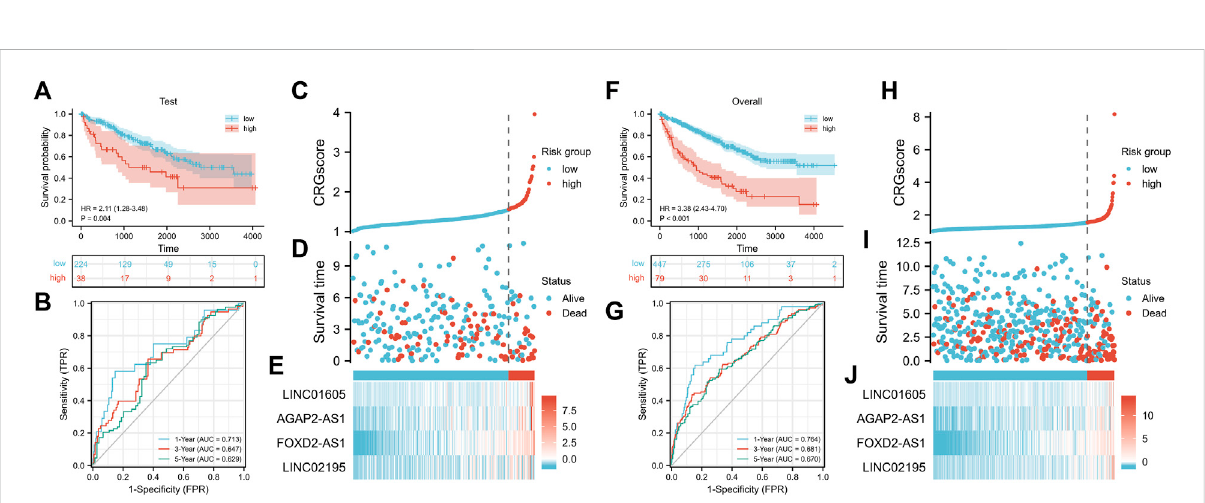
FIGURE 6 Veri fi cation of the prognostic signature. (A) Survival analysis of the CRGscore-de fi ned test cohort. (B) Time-dependent ROC curves. (C – E) Distribution of the CRGscore (C) , OS outcomes (D) , and hub lncRNAs expression (E) in the test cohort. (F) Survival analysis of the CRGscore-de fi ned overall cohort. (G) Time-dependent ROC curves. (H – J) Distribution of the CRGscore (H) , OS outcomes (I) , and hub lncRNAs expression (J) in the overall